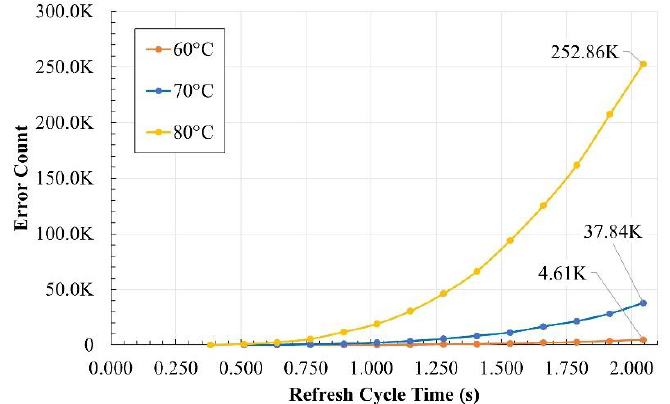
Figure 14. Retention error counts with varying RCT at T L of 60 °C, 70 °C, and 80 °C in Pseudo channel 0 of Channel 0.